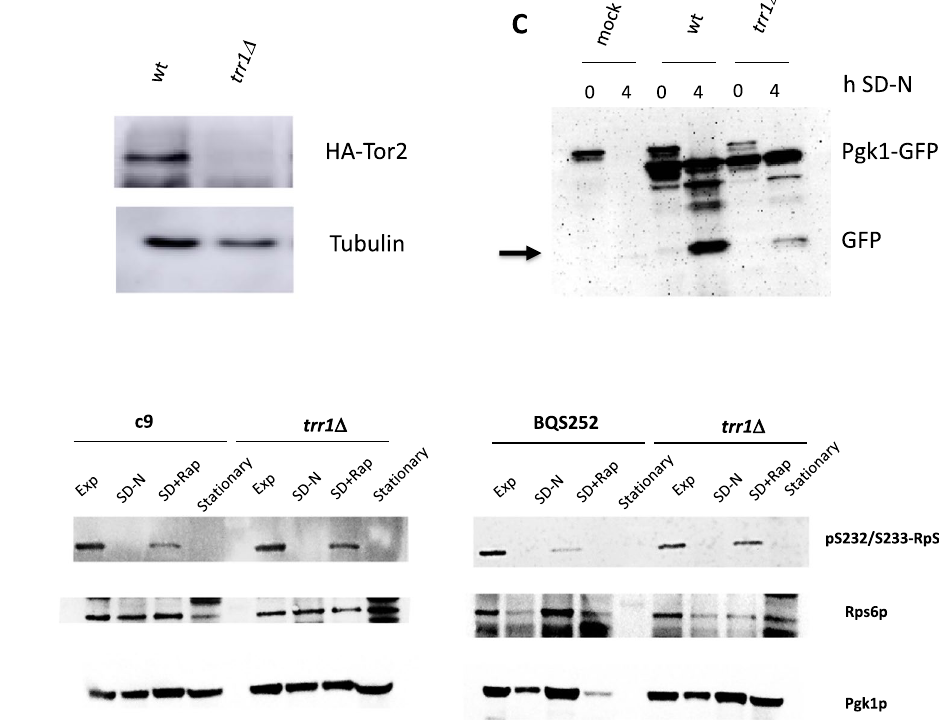
Figure 6. The trr1 Δ mutant has altered Tor2 levels and TORC1 activity. ( A ) Western blot analysis against a HA-tagged version of TOR2 in the BQS252 and its trr1 Δ mutant. Cells were grown for 4 hours in galactose to express the construct. An antibody against HA tag was used to detect the protein level. Tubulin was used as a loading control. ( B ) Western blot against the phosphorylated isoform of ribosomal protein Rps6. The TRR1 deletions in both wine yeast strain C9 and laboratory strain BQS252 were tested against rapamycin treatment, nitrogen starvation and in the stationary phase. Total Rps6 and Pgk1 were used as loading controls. ( C ) The autophagy analysis under nitrogen starvation of the Pgk1-GFP fusion of the trr1 Δ mutant. The arrow indicates the GFP fragment that marks